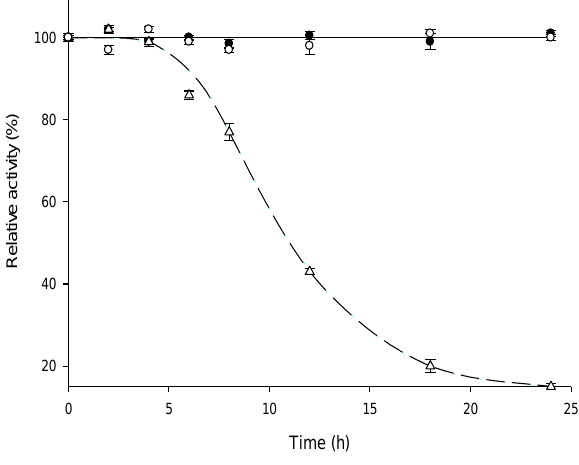
Figure 3. Thermal inactivation at 60 ° C and pH 8 of (∆) soluble Tt HGXPRT, (●) M Tt HGXPRT3, and ( ○ ) M Tt HGXPRT5.